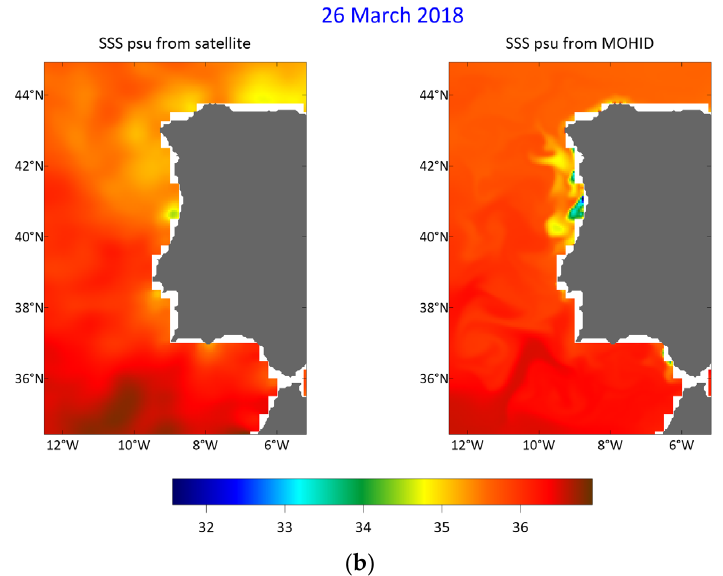
Figure 11. Daily Sea surface salinity for 24 March 2018 ( a ) and 26 March 2018 ( b ) from the BEC-SMOS Global L4 V2 (Left) and surface layer of PCOMS model with LAMBDA Complete Observations scenario (Right). Basic comparison statistics for ( a ) are: Average PCOMS SSS: 35.936; Average SMOS SSS: 35.892; Coef. Correlation; 0.702; Bias: 0.045 and RMSE: 0.218. Basic comparison statistics for ( b ) are: Average PCOMS SSS: 35.929; Average SMOS SSS: 35.884; Coef. Correlation; 0.676; Bias: 0.045 and RMSE: 0.275.